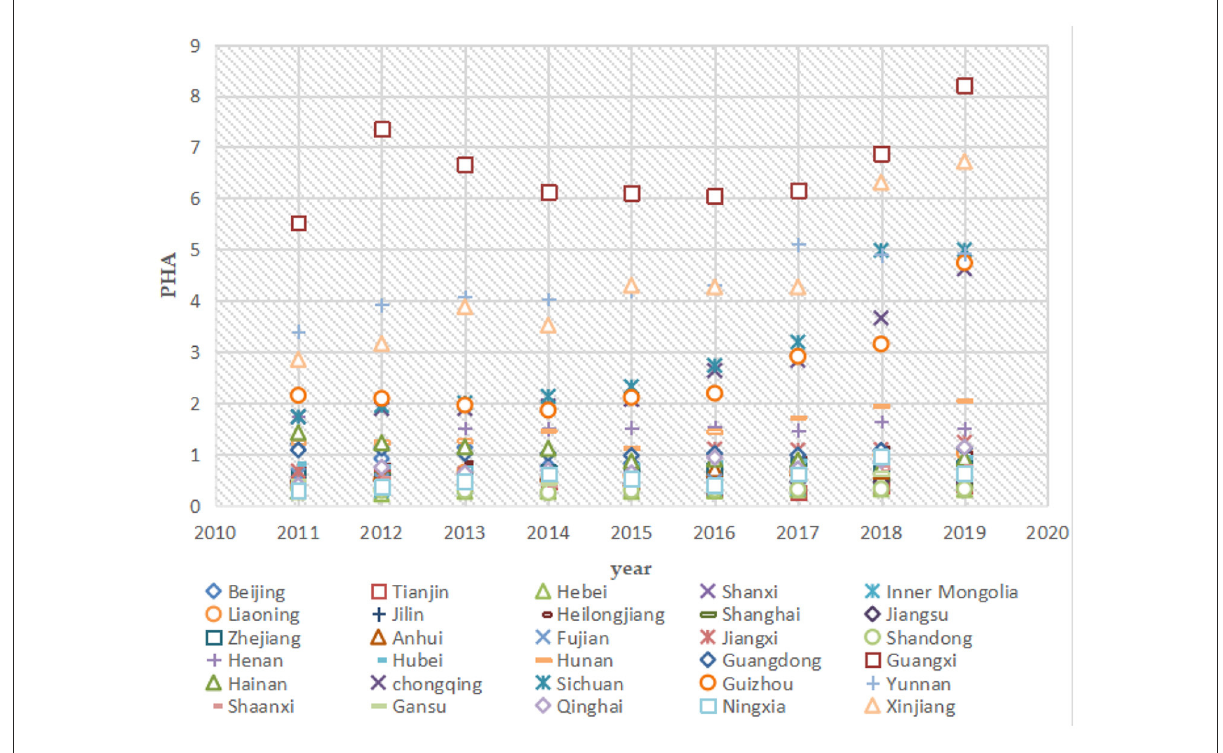
FIGURE9 Public safety indicators for 30 Chinese provinces, 2011 to 2019.